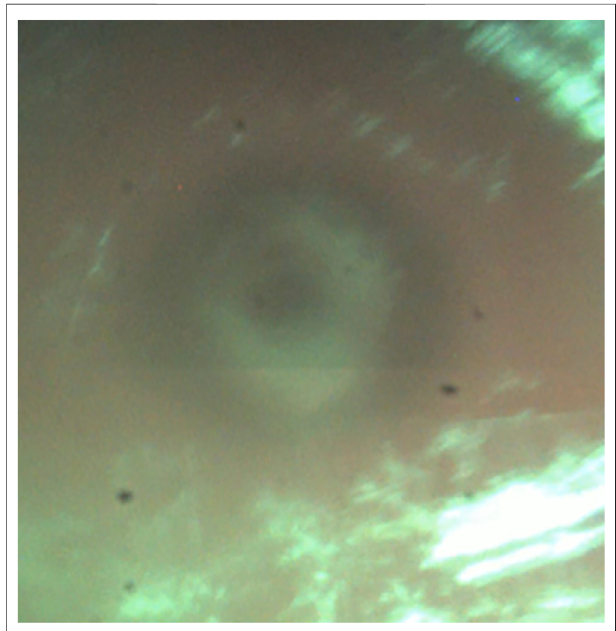
FIGURE 8 | Contrast difference in the middle of a bone channel at cut